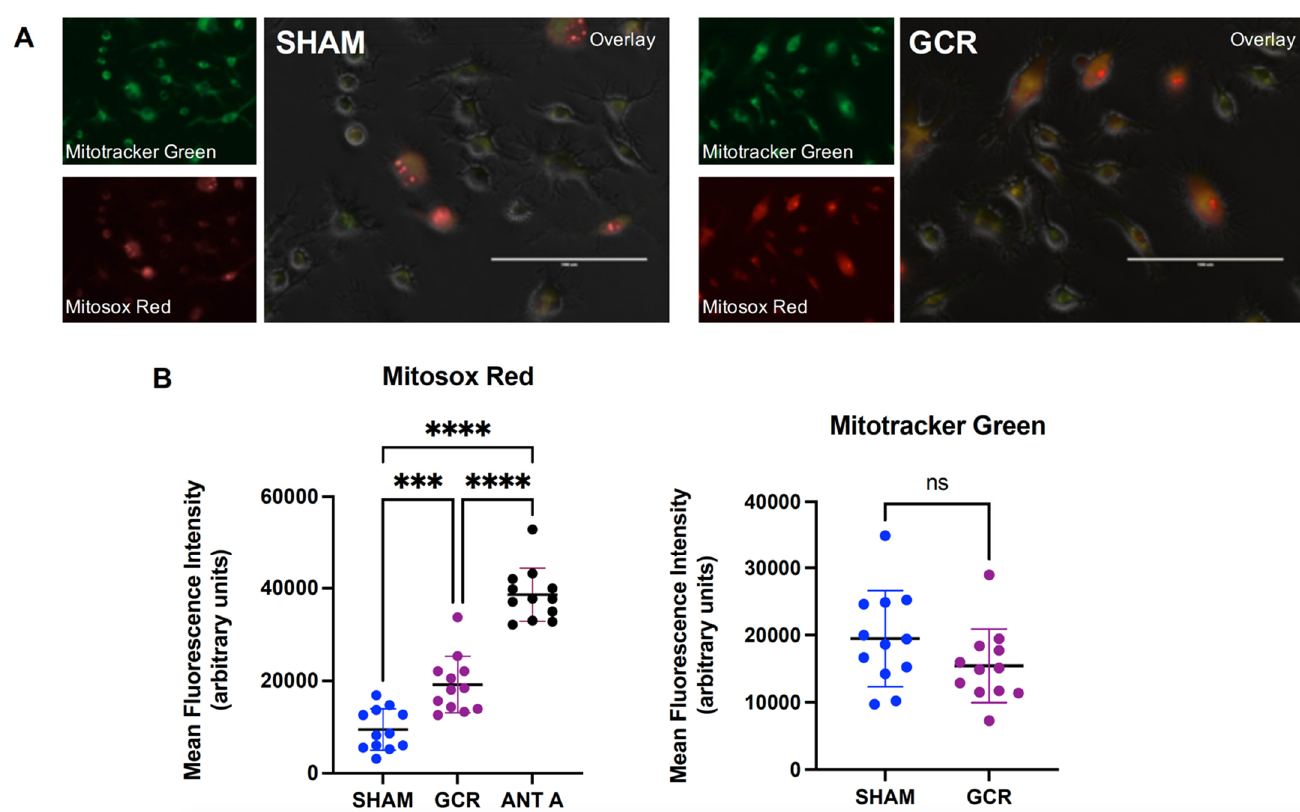
Figure 6. Exposure to 0.5 Gy GCR increases mitochondrial ROS in vitro. Bone marrow macrophages were isolated from 9-month-old male BalbC sham or GCR exposed mice 3 months after the mice were irradiated and cultured with M-CSF (30 ng/mL) and RANKL (30 ng/mL) for 3 days. Cells were simultaneously stained with 2 µ M MitoSOX Red (upper left images) and 100 nM MitoTracker Green (bottom left images) for 20 min. ( A ) The epifluorescent pictures of randomly chosen 12 areas were then taken using a fluorescent microscope in a blinded fashion. Antimycin A (10 μ M) was used as the positive control. ( B ) The images were also analyzed with ImageJ software in a blinded fashion. Each area had between 18–53 cells and the fluorescent intensities of each cell were measured. MitoTracker Green and MitoSOX results were presented as mean fluorescent intensity (MFI) per cell in arbitrary units. Data are presented as ± SEM. p values were determined using Student’s t -test between the two groups (n = 12, n.s. not significant). When there were 3 groups, one-way ANOVA with Tukey’s post-hoc test was utilized (n = 12, *** p < 0.001, **** p < 0.0001).